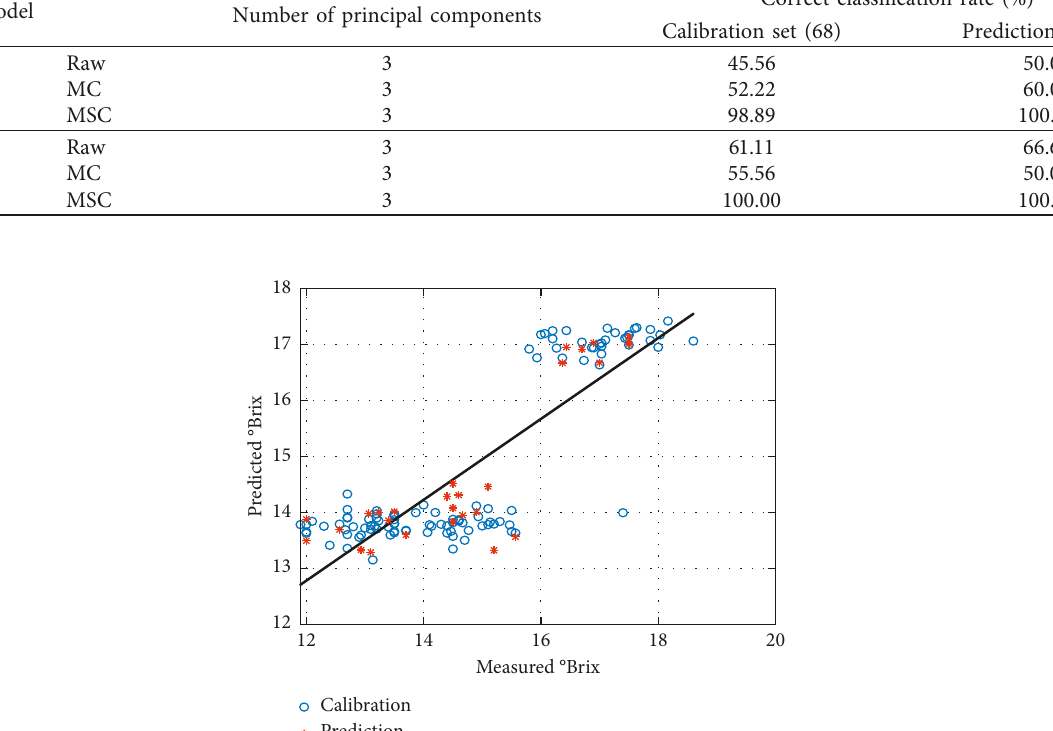
Table 2: The performance of classification models influenced by preprocessing techniques.